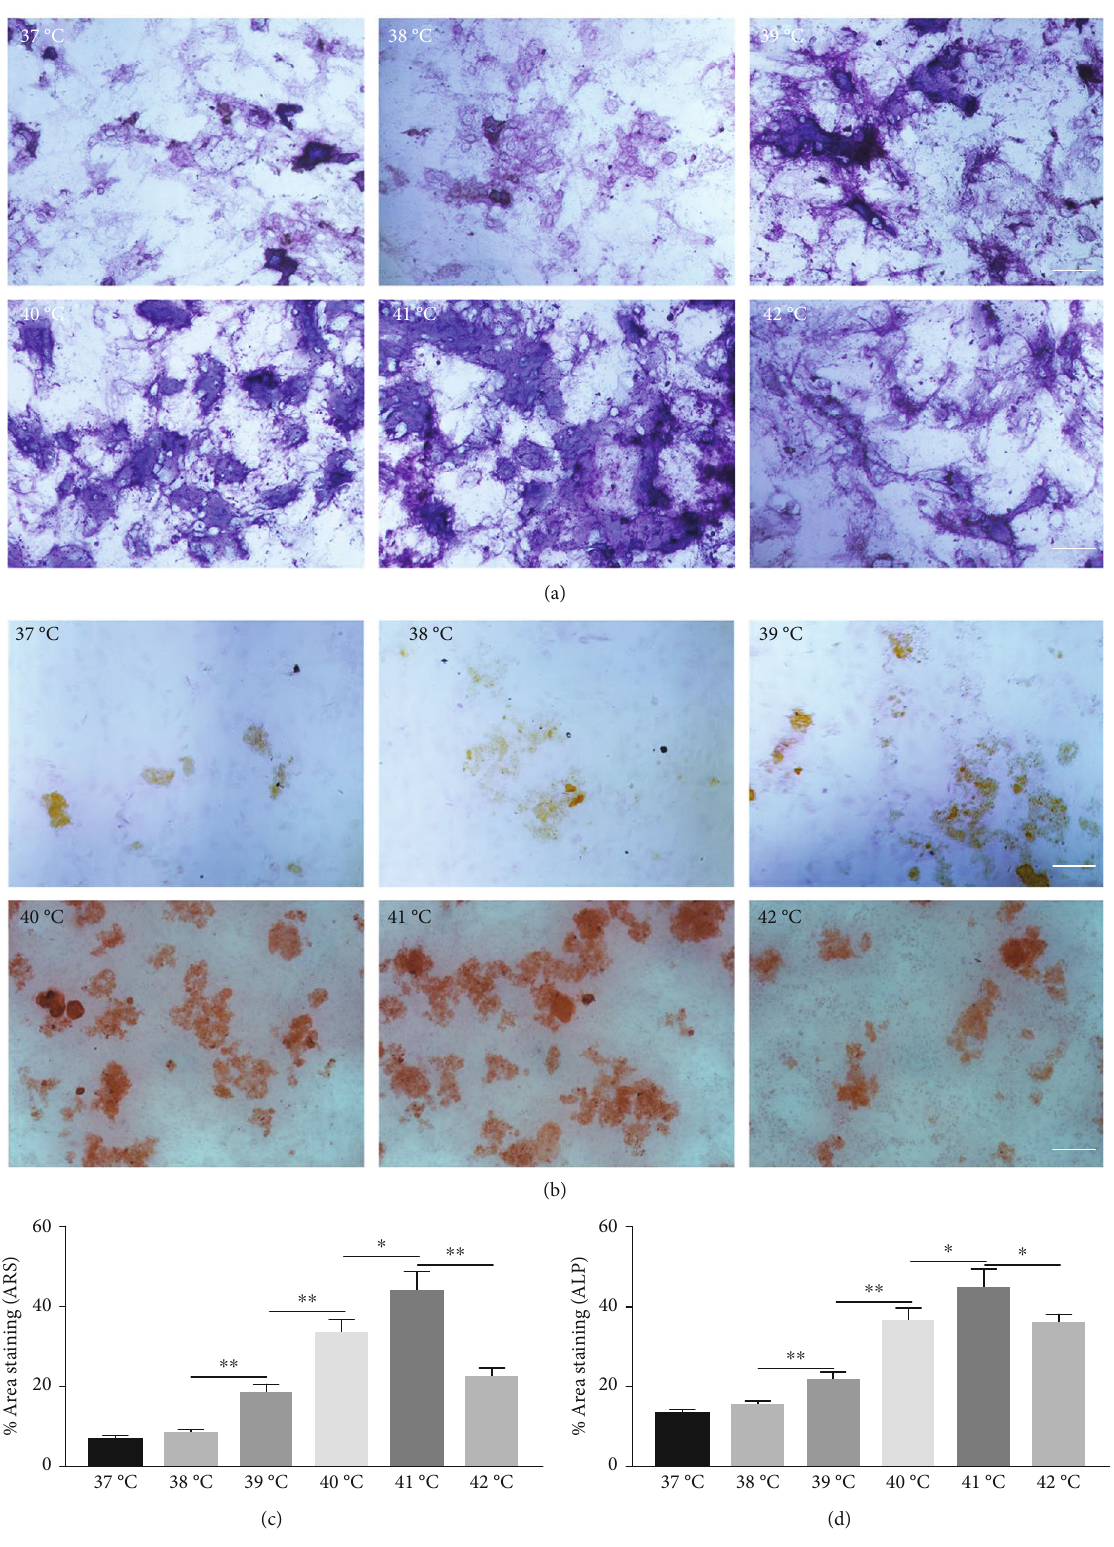
Figure 3: E ff ects of di ff erent heat stresses on the osteogenic di ff erentiation of EMSCs cultured in osteogenic medium after 7 days using ALP and Alizarin red S staining. (a, b) Osteogenic di ff erentiation was determined by performing ARS and ALP staining to indicate mineralization and di ff erentiation, respectively. Measured areas of mineralized nodules from (c) ARS staining and (d) ALP activity. EMSCs exposed to heat stress at 41 ° C had larger areas of mineralized nodules and ALP activity, indicating greater osteogenic di ff erentiation. Data are presented as the means ± SD of at least three independent experiments. ∗ P < 0 : 05 and ∗∗ P < 0 : 01